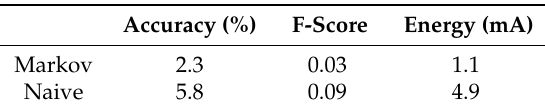
Table 4. The average prediction error of assignments in the non-dominated set, made on energy consumption, F-score and classification error for the naive and Markov chain model.